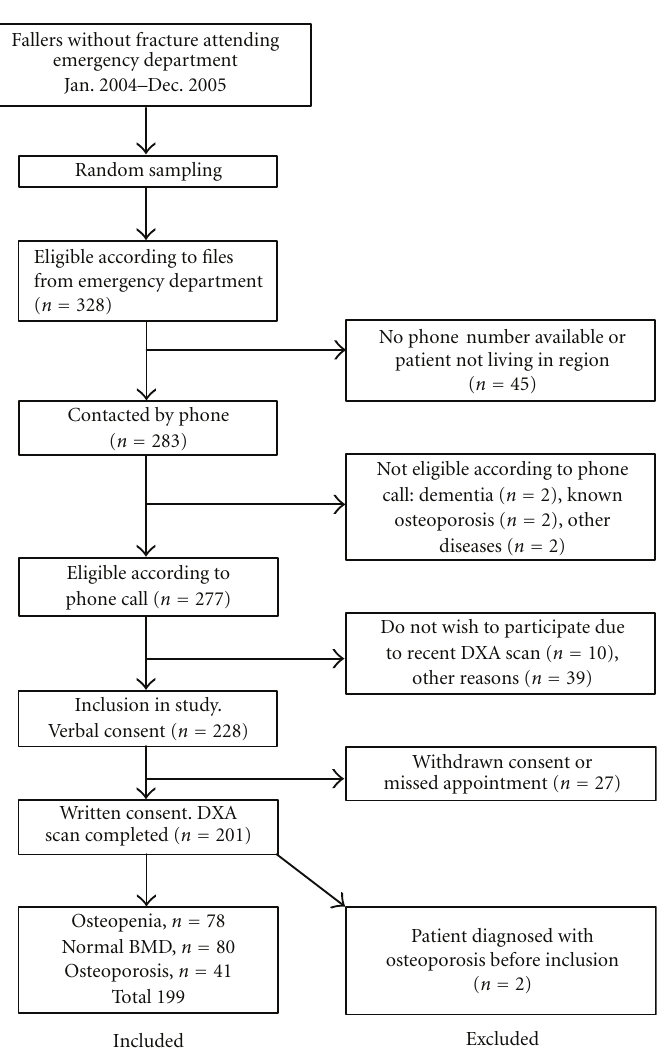
Figure 1: Trial profile: Number of fallers included or excluded in the study.